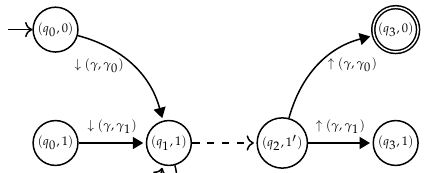
. a ∗ (cid:104) (cid:105)